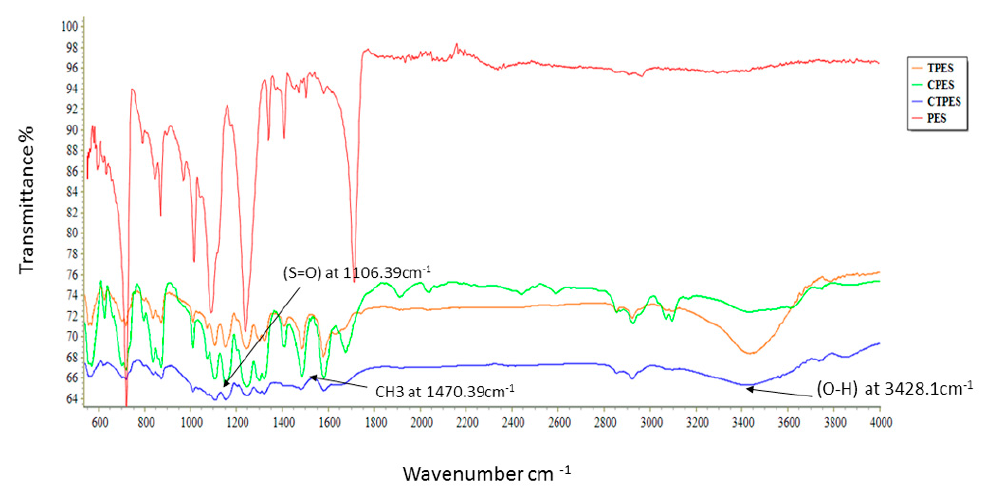
Figure 2. FTIR analysis of pure polyethersulfone (PES), cannabinoid and terpene embedded polyethersulfone (CT-PES), terpene embedded polyethersulfone (T-PES), and cannabinoid embedded polyethersulfone (C-PES) membranes.